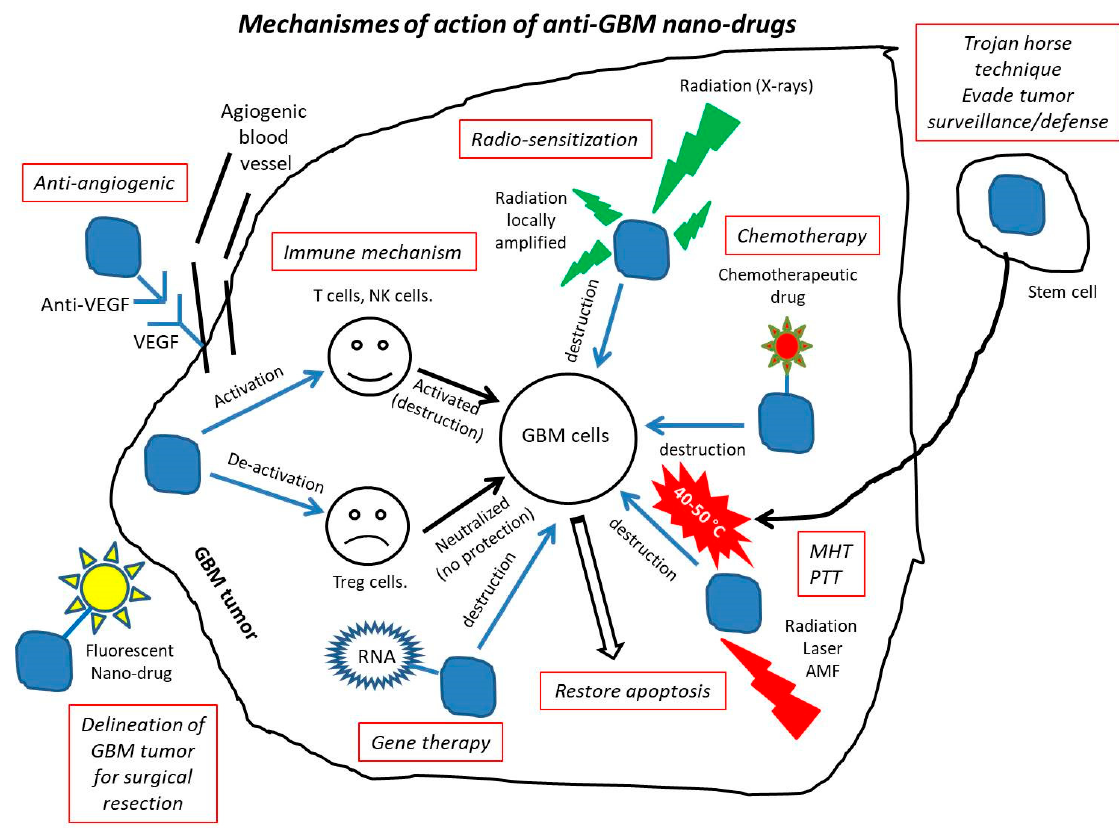
Figure 3. A schematic figure presenting the various mechanisms of action of anti-GBM drugs.